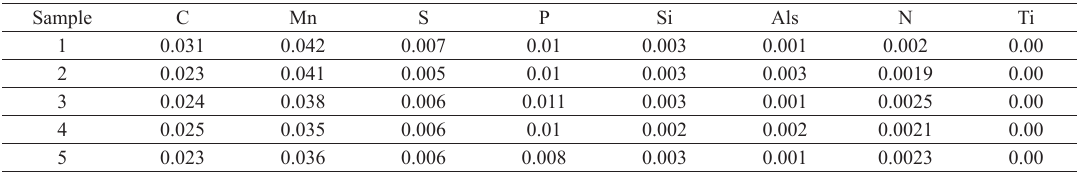
Table 3. The chemical compositions of the steel samples at the end of LF process /%. Sample